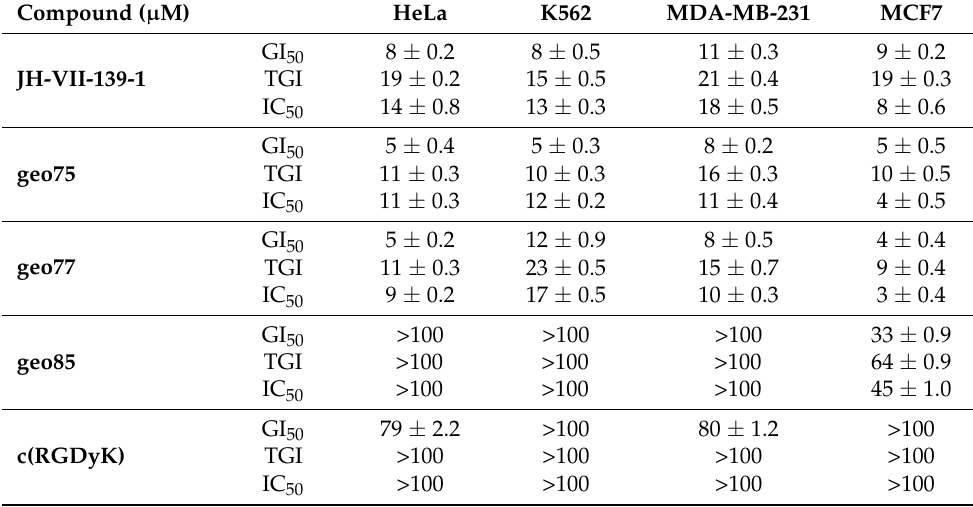
Table 3. Growth inhibition/cytostatic (GI 50 and TGI) and cytotoxic/cytocidal (IC 50 ) anticancer effects induced by JH-VII-139-1, c(RGDyK), and JH-VII-139-1-c(RGDyK) hybrid compounds against a panel of cancer cell lines after 48 hrs. Results are presented as mean ± SD of three independent